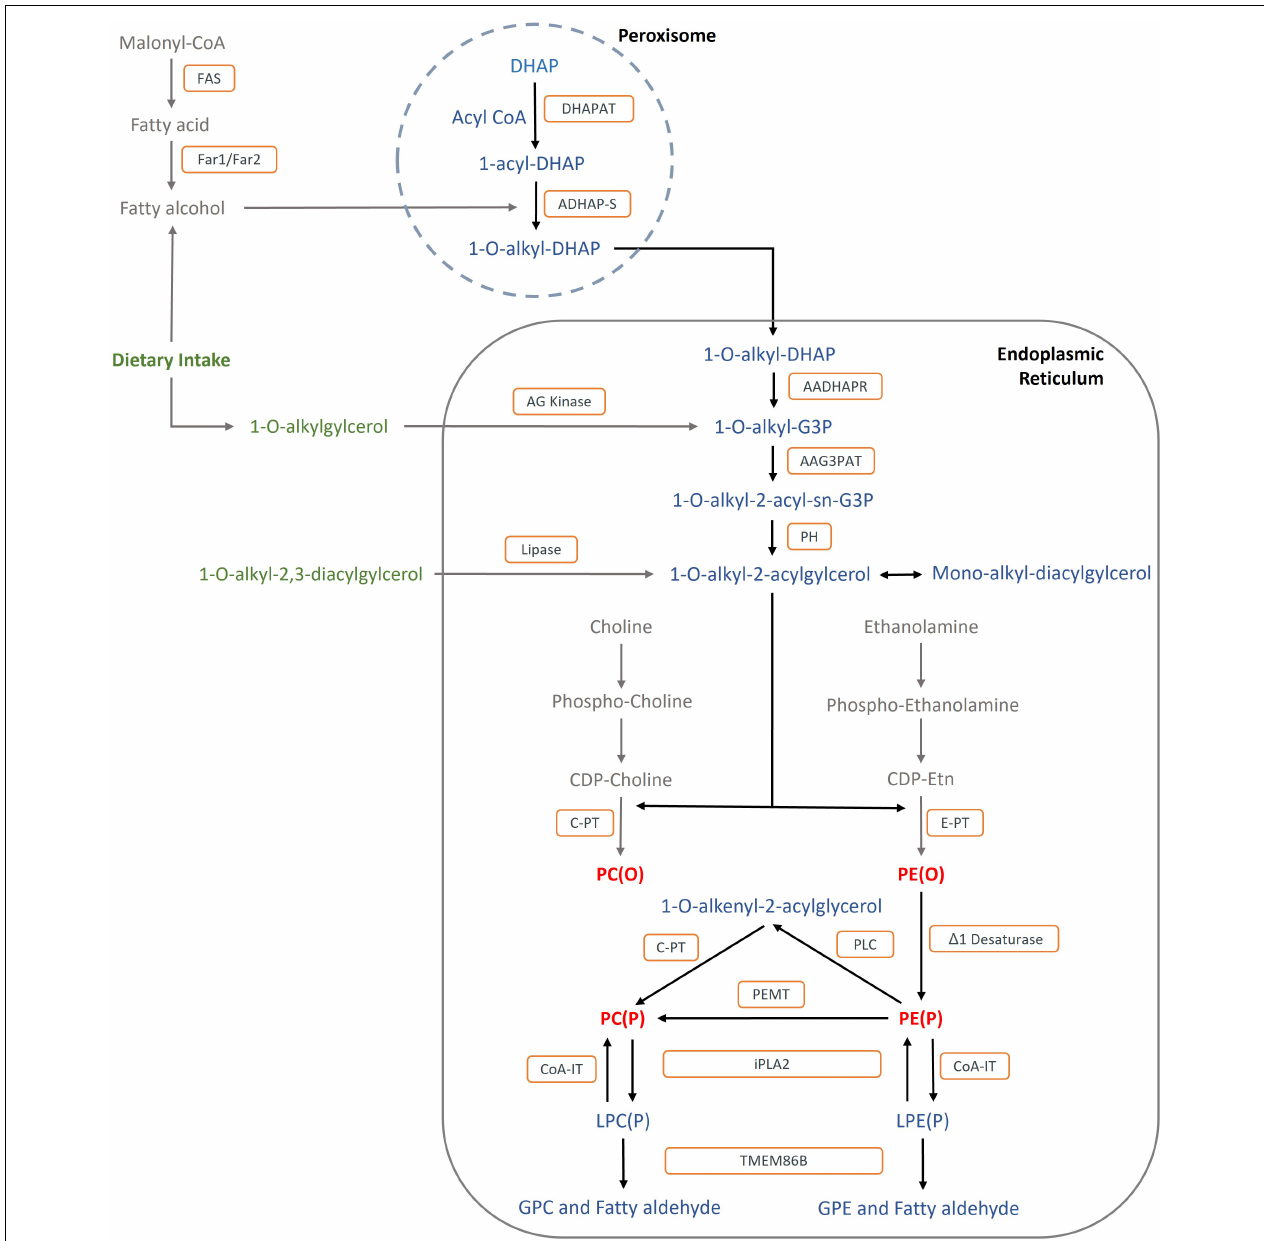
FIGURE 2 | Biosynthetic and catabolic pathways of ether lipids: The formation of fatty alcohol by FAR1 and FAR2 in the peroxisome is the rate-limiting step: Metabolites are shown in blue and red: DHAP, dihydroxyacetonephosphate; G3P; glycerol-3- phosphate GPC, glycerophospho-choline; GPE, glycerophospho-ethanolamine; PC(O), Alkyl-phosphatidylcholine; PE(O), Alkyl-phosphatidylethanolamine; PC(P), PC plasmalogen, PE(P), PE Plasmalogen; LPC(P), Lyso-PC Plasmalogen; LPE(P), Lyso_PE Plasmalogen. Enzymes are shown in orange squares: DHAPAT, DHAP acyltransferase; ADHAP-S, alkyl- dihydroxyacetone phosphate synthase; AADHAPR, acyl/alkyl dihydroxyacetone phosphate reductase; AAG3PAT, acyl/alkyl-glycero-3- phosphate acyltransferase; PH, phosphohydrolase; AG kinase, alkylglycerol kinase; δδ 1 Desaturase, plasmanyl-ethanolamine delta1-desaturase; C-PT, choline phosphotransferase; E-PT, ethanolamine phosphotransferase; PEMT, phosphatidylethanolamine N-methyltransferase; PLC, phospholipase C; CoA-IT, coenzyme A-independent transacylase; i-phospholipase A2, calcium independent phospholipase A2; TMEM86B, lysoplasmalogenase; FAR1, fatty acyl-CoA reductase 1; FAR2, fatty acyl-CoA reductase